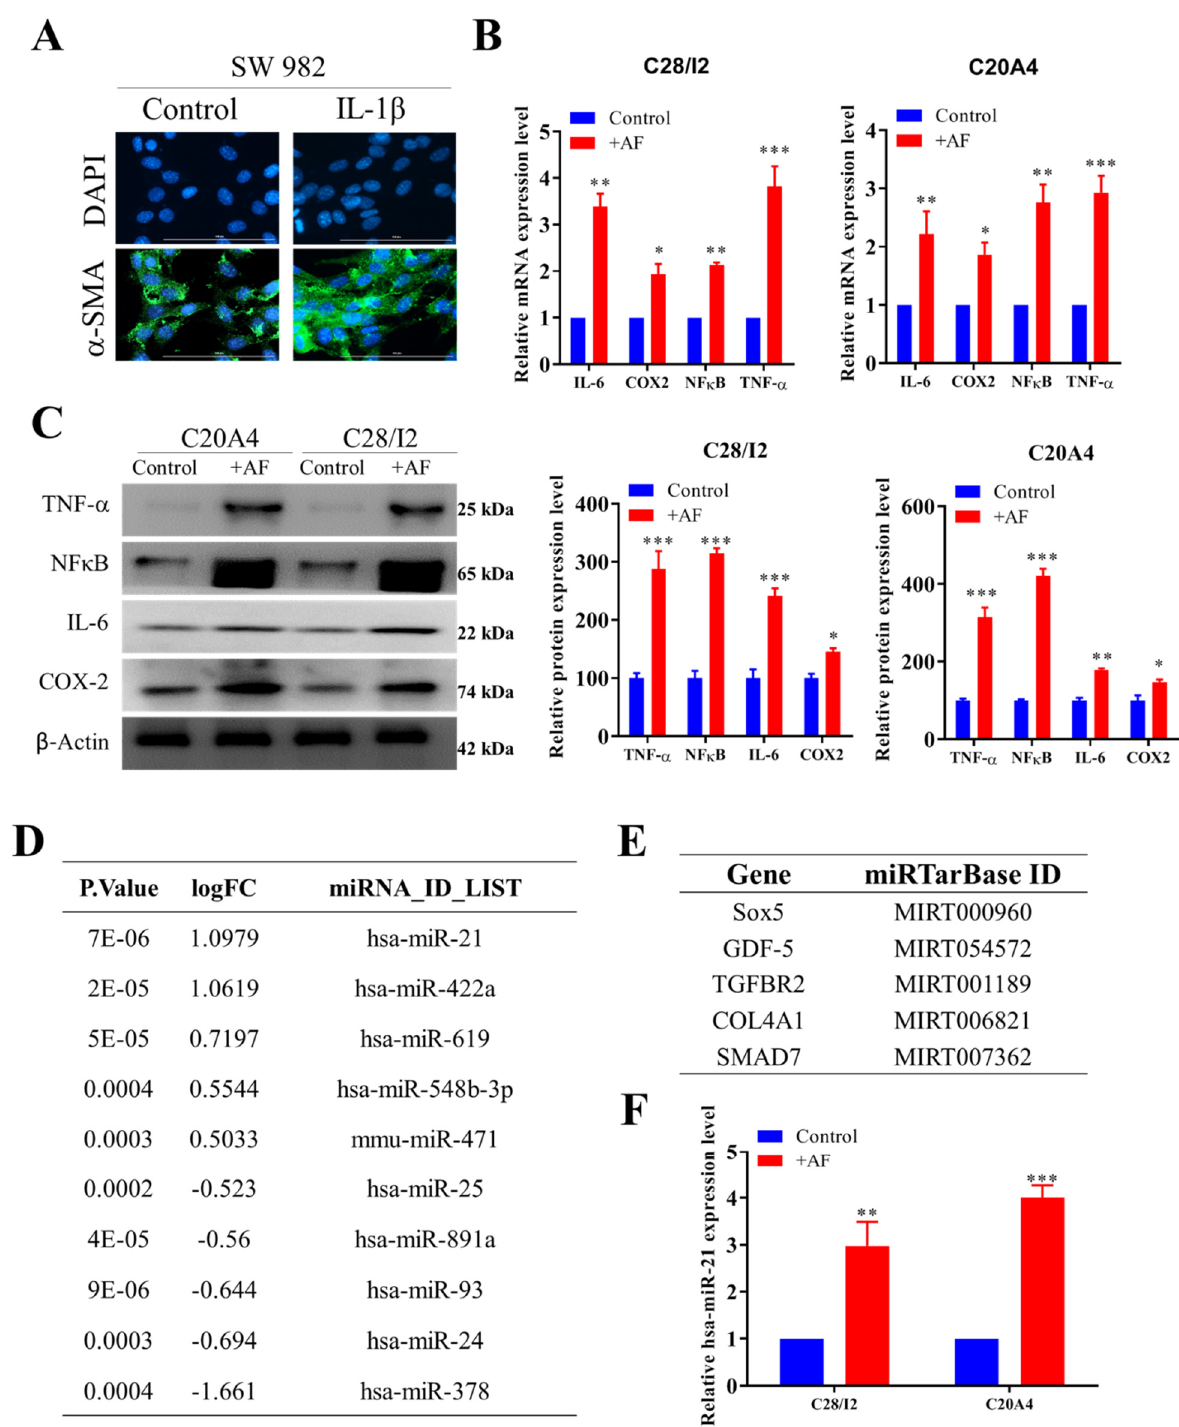
Figure 1. IL-1 β signaling promotes the generation of activated fibroblasts. ( A ) Immunofluorescence analysis indicated that IL-1 β treatment transformed SW982 cells into the AF phenotype. Green fluorescence indicates α -SMA labelling. ( B ) Human chondrocyte cell lines, C28/I2 and C20A4 exhibited increased levels of inflammatory markers after coculturing with AFs. ( C ) Comparative profiling between naïve chondrocytes and AF-cultured chondrocytes. Increased expression of TNF- α , NF κ B, IL-6, and Cox2 was found in both C28/I2 and C20A4 cells after coculturing with AFs. ( D ) A bioinformatics search of the GSE37627 database identified miR-21 as one of the miRs with the greatest magnitude of increase in AFs compared with normal fibroblasts. ( E ) Experimentally validated targets of miR-21 in association with chondrogenesis. ( F ) Increased miR-21 levels in AF-educated C28/I2 and C20A4 chondrocytes. Scale bar = 50 μ m. * p < 0.05, ** p < 0.01 and *** p < 0.001.